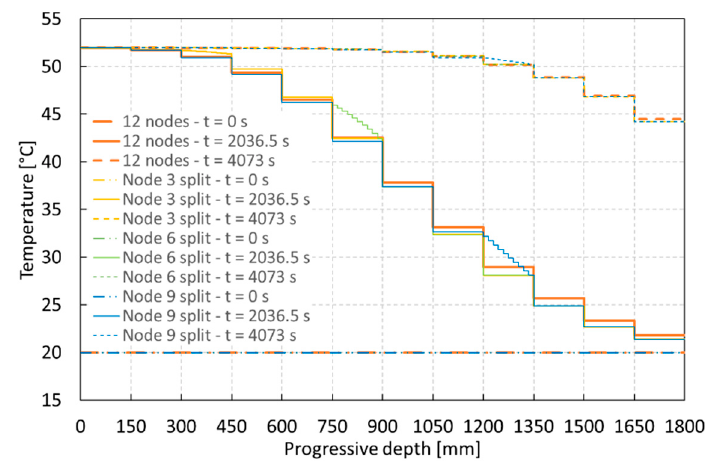
Figure 14. Temperature stratification (during the charge phase) inside the storage tank at three di ff erent simulation stages.